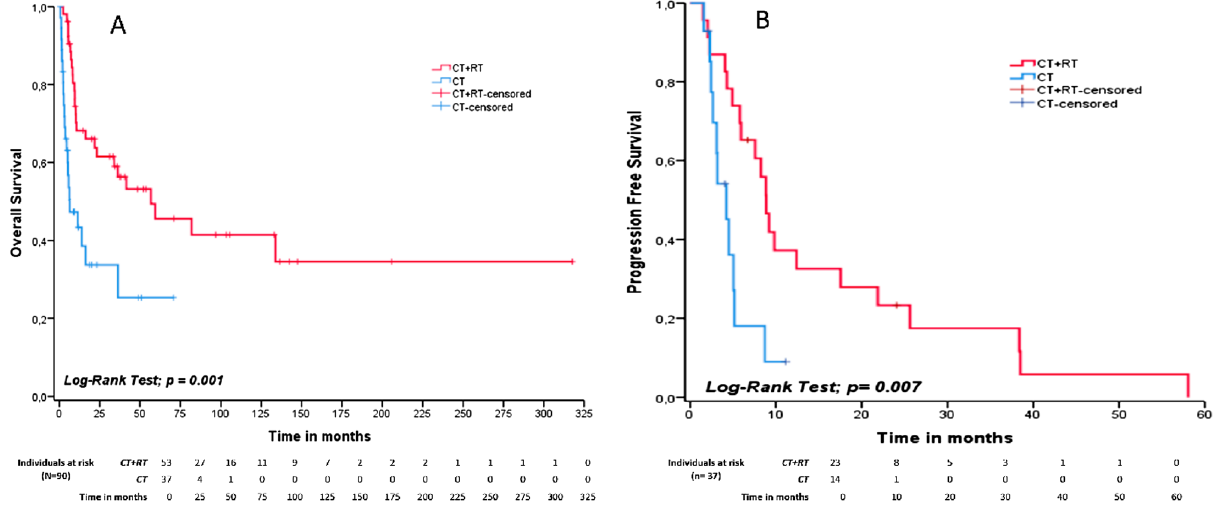
Figure 3. OS ( A ) and PFS ( B ) for 90 Brazilian patients with ENKTL comparing up-front treatment modalities. Red-line represents patients treated with CRT and blue-line represents cases treated with chemotherapy alone. Univariate analysis Multivariate